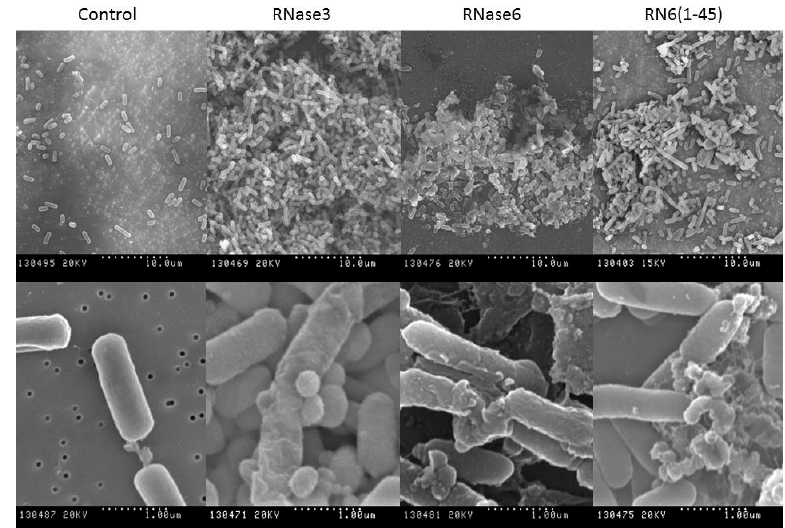
Figure 4. SEM micrographs for E. coli cultures incubated in the absence and presence of RNase3, RNase6 and RN6(1–45). Two magnifications ( upper and lower panels) are shown for each condition to visualize the extent of bacteria aggregates and cell morphology. The magnification scale is indicated at the bottom of each